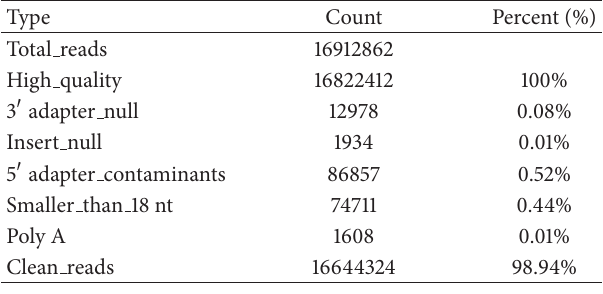
Table 1: Summary of data cleaning.